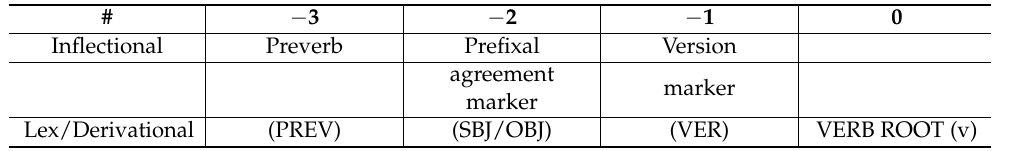
Table 1. Prefixal domain of Georgian verbs.